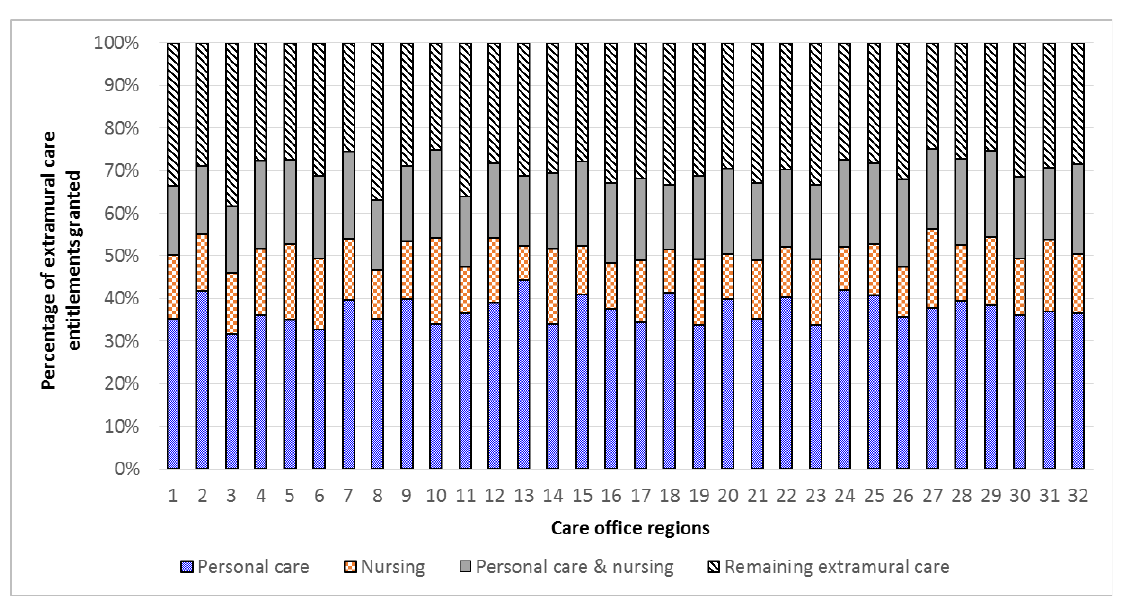
The percentage of a specific type of publicly financed home care granted relative to the total number of publicly financed home care granted per care office region